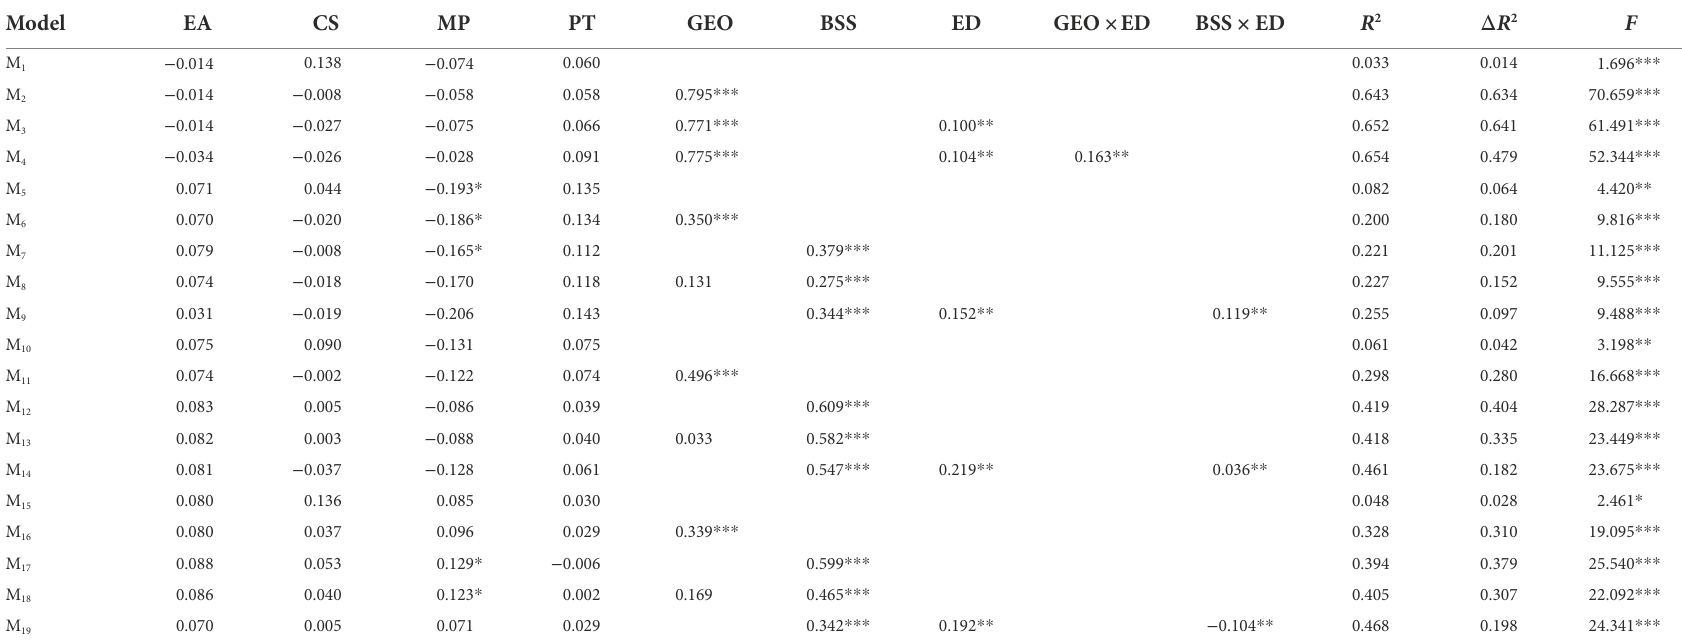
TABLE 5 Regression analysis